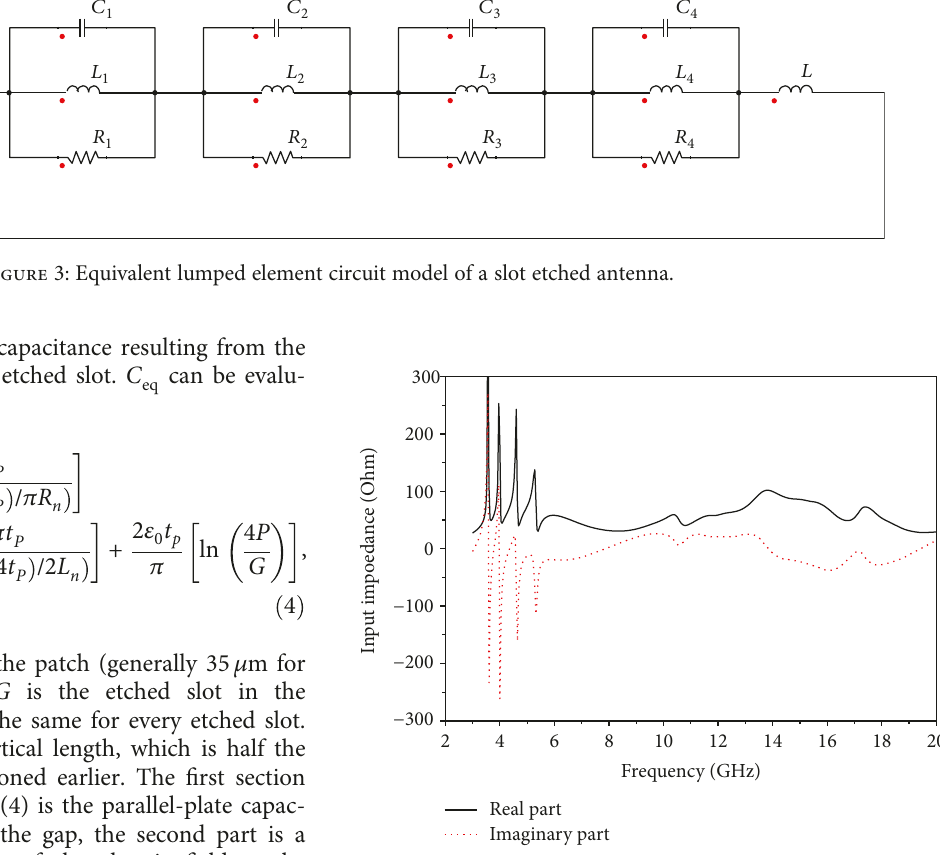
Figure 4: Input impedance of the proposed